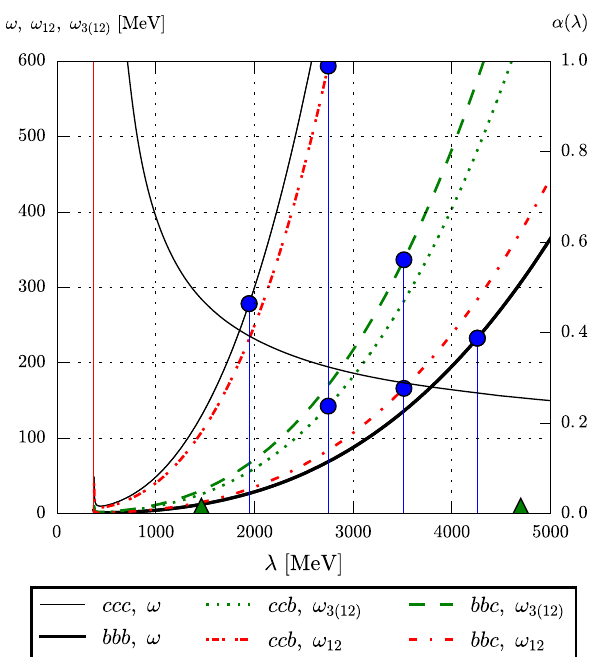
Fig. 7 Dependence of the harmonic-oscillator frequencies on the RGPEP scale λ and quark masses (left axis), and the dependence of α on λ (right axis). For detailed description of this figure content,